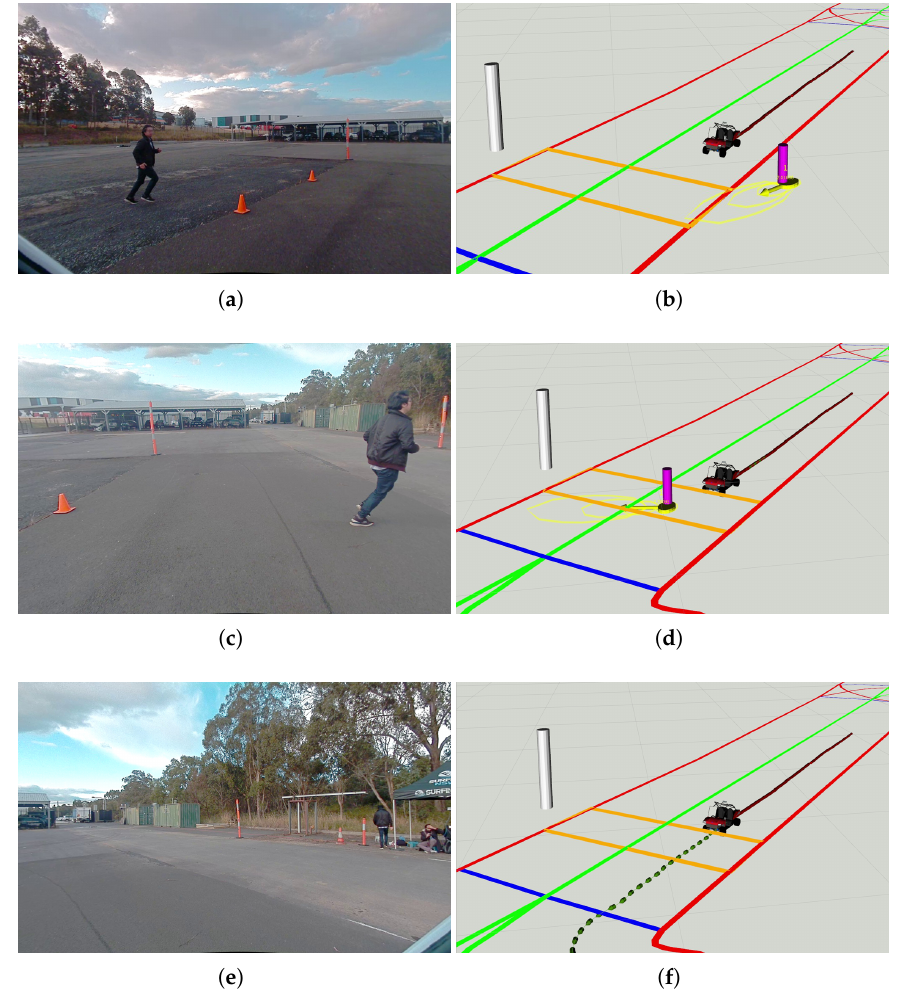
Figure 22. The CAV gave way to a running pedestrian at the designated crossing area in a lab environment. Based on the ETSI CPMs broadcast by the IRSU, the CAV predicted the state of the running pedestrian up to 1.5 s into the future. The IRSU is visualised as a tall white pillar in the CAV in ( b , d , f ). It is seen in ( b ) that the predicted states of the pedestrian, visualised as yellow ellipses, intersected with the orange crossing area on the Lanelet2 map. The CAV stopped for the pedestrian in front of the crossing in ( d ). The CAV then planned a new path forward after the pedestrian finished crossing in ( f ). In ( a , c , e ), image frames from front-left, front-centre, front-right cameras on the CAV are presented, respectively.